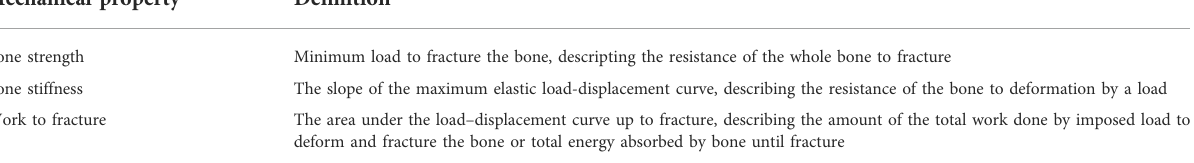
TABLE 1 De fi nitions of the mechanical